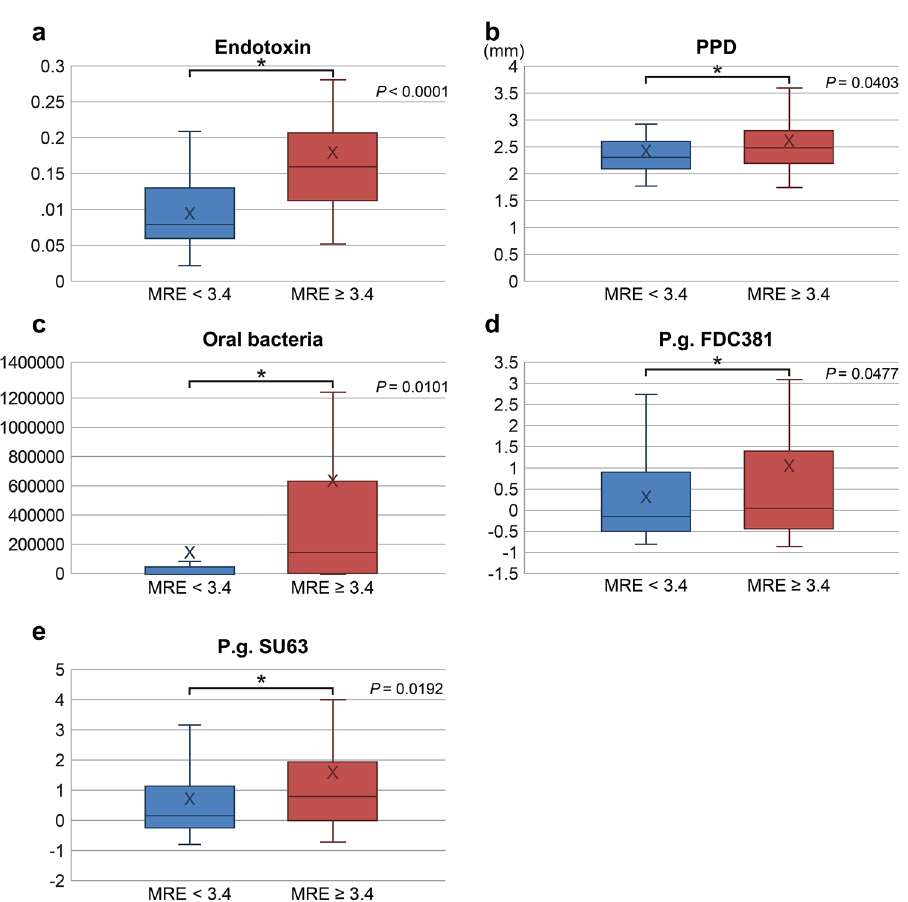
Figure 2. Endotoxin activity ( a ), PPD ( b ), periodontal disease-causing bacteria, P. gingivalis ( c ), antibody titer for P. gingivalis FDC381 ( d ), and antibody titer for P. gingivalis SU63 ( e ) in the groups with MRE < 3.4 kPa and MRE ≥ 3.4 kPa. MRE magnetic resonance elastography, PPD periodontal pocket